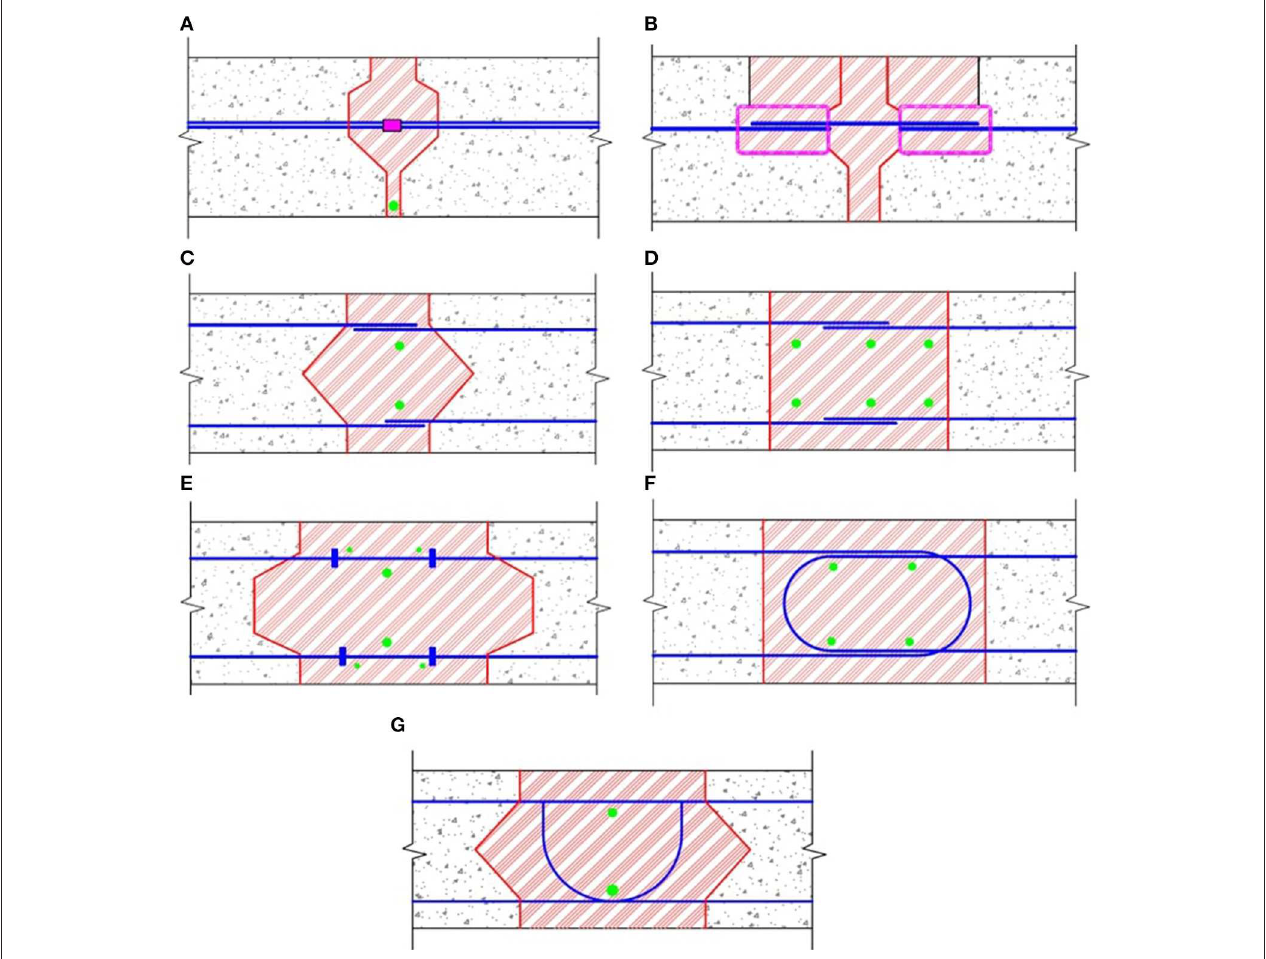
FIGURE 2 | Schematic for common closure joints in ABC. (A) posttensioning, (B) mechanical connectors, (C) ultra-high performance with straight bars, (D) normal-strength concrete with straight bars, (E) normal-strength concrete with headed bars, (F) normal-strength concrete with 180 ◦ hooked bar, (G) normal-strength concrete with 90 ◦ hooked bar (recently